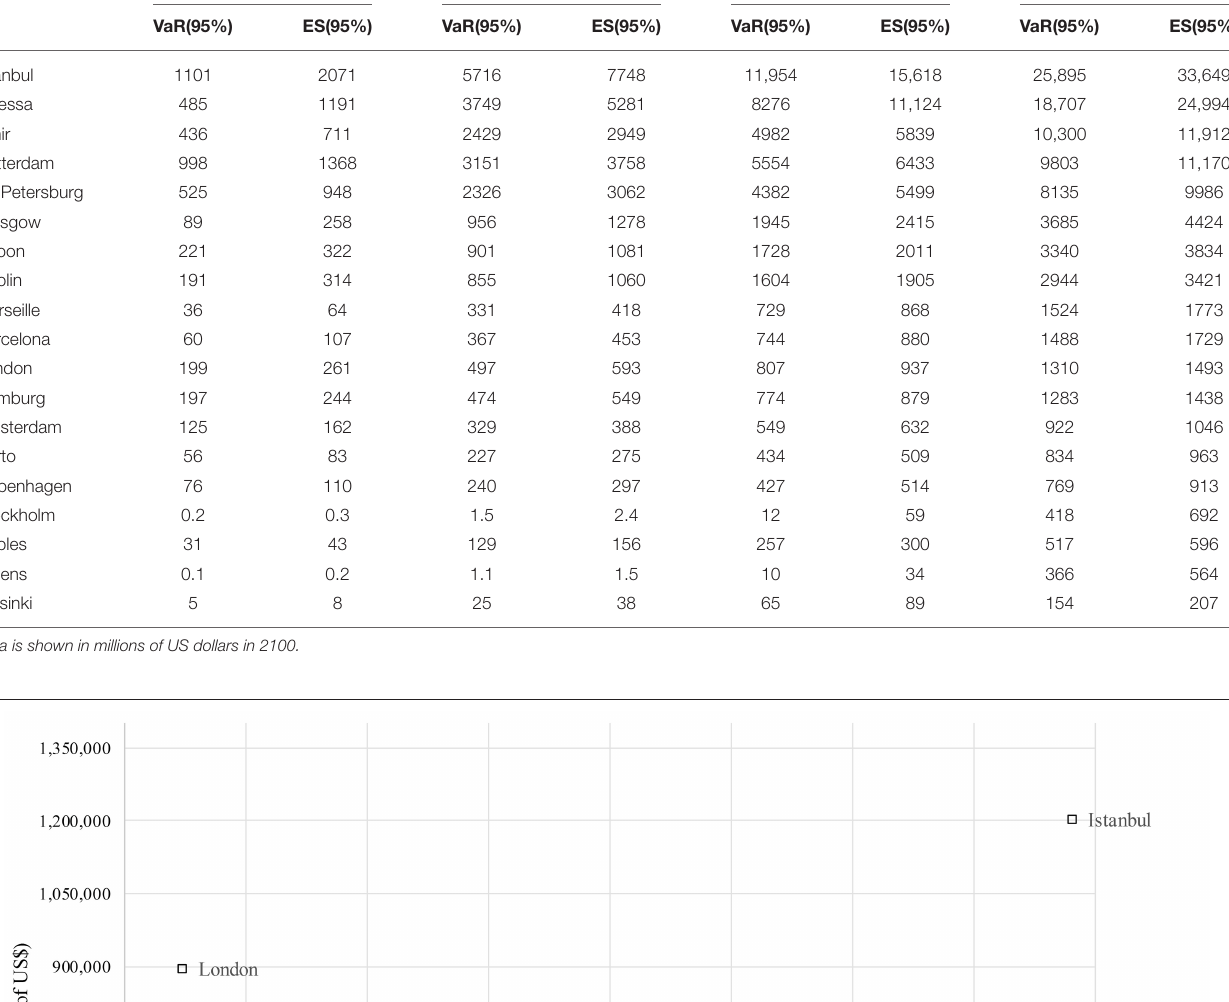
TABLE 5 | Risk for main European coastal cities ranked by Expected Shortfall (ES). City